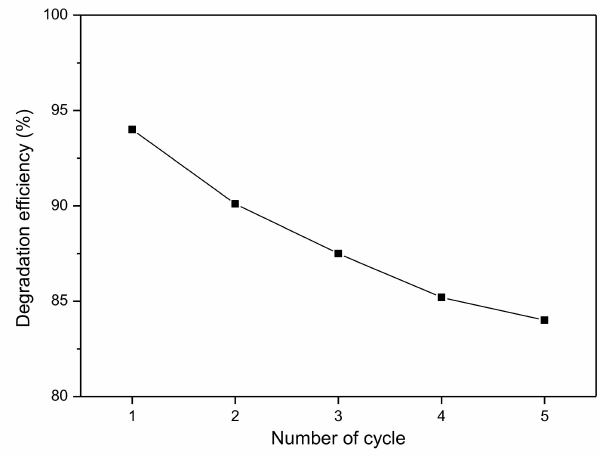
Figure 10. Reusability performance of g-C 3 N 4 / TiO 2 / hectorite composite towards